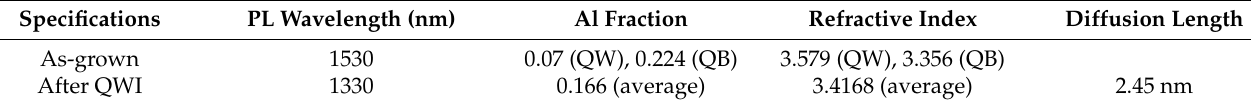
Figure 3. ( a ) Al composition and ( b ) reflective index distribution at 1.5 µm wavelength through one period of the MQW after intermixing by 200 nm.